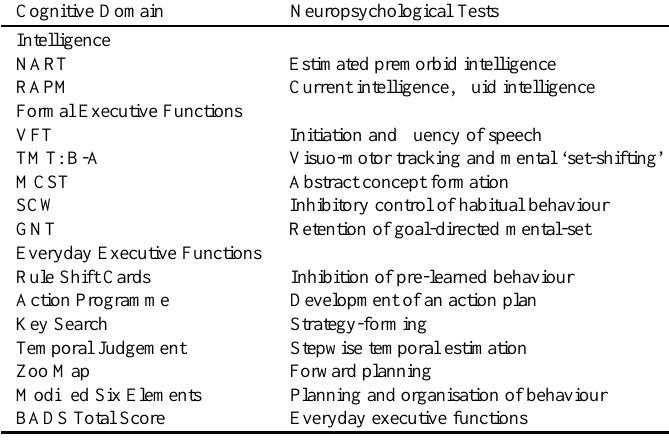
Table 3 Cognitive domains examined by the neuropsychological test